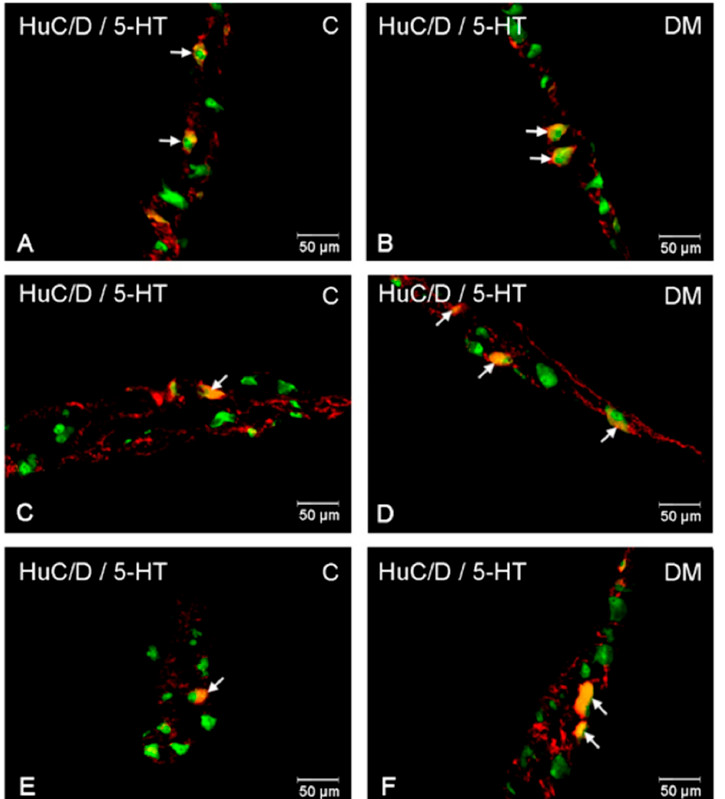
Figure 6. Immunofluorescent microphotographs showing serotonin immunoreactive perikarya in jejunum in the myenteric plexus of the control ( A ) and in experimental group ( B ); inner submucosal plexus of the control ( C ) and in experimental group ( D ); outer submucosal plexus of the control ( E ) and in the experimental group ( F ). (C)—control group; (DM)—diabetes mellitus. Photographs in the right column were created by digital superimposition of two-color channels; Hu C/D (green)- and serotonin-positive (red). The arrows indicated studied cells’ bodies.